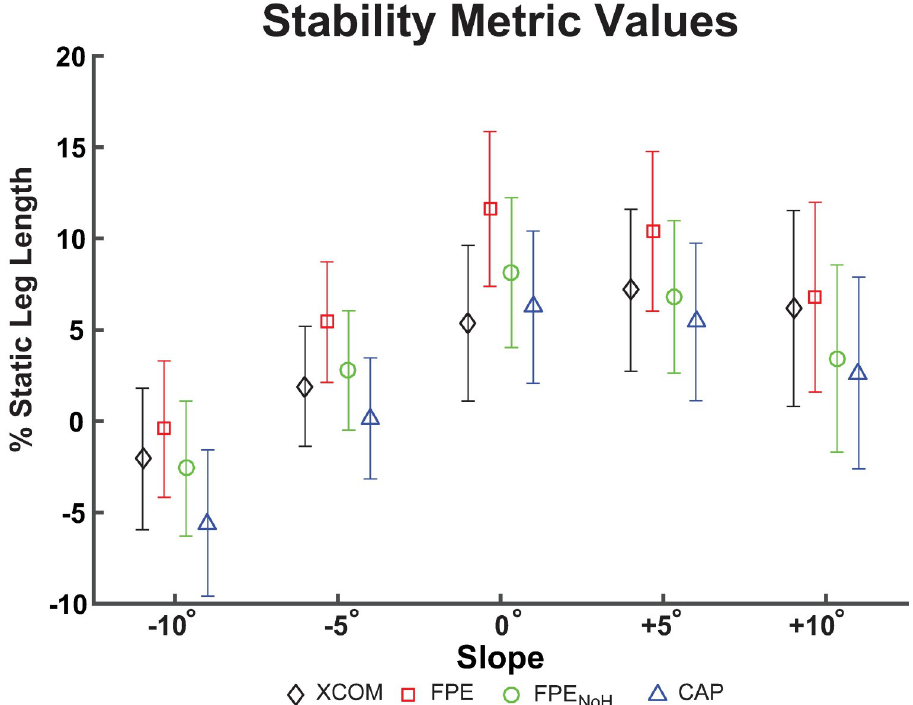
Fig 2. Stability metric values. Mean ( ± SD) stability metrics, computed as the distance between the toe marker and extrapolated center of mass (XCOM, black diamonds), foot placement estimate (FPE, red squares), foot placement estimate with no angular momentum (FPE NoH , green circles) and capture point (CAP, blue triangles) at heel strike, normalized to percent static (i.e., standing) leg length. Positive values are defined as “stable” (toe anterior to stability location), and negative values are “unstable” (toe posterior to stability location) by the metric definitions.